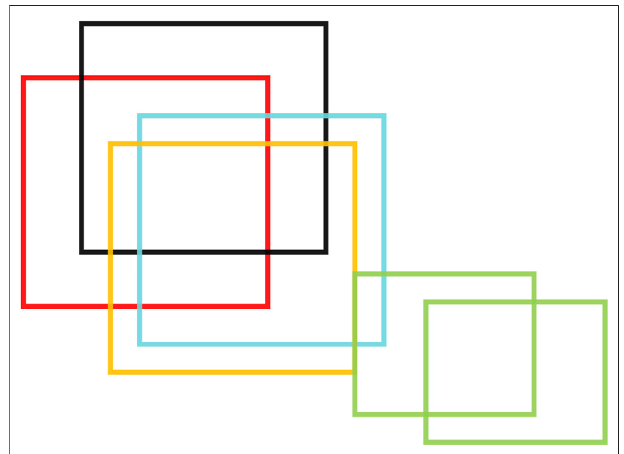
FIGURE 7 | Example for cluster operation, the black, red, blue, and orange boxes constitute a cluster, while the two green boxes constitute a